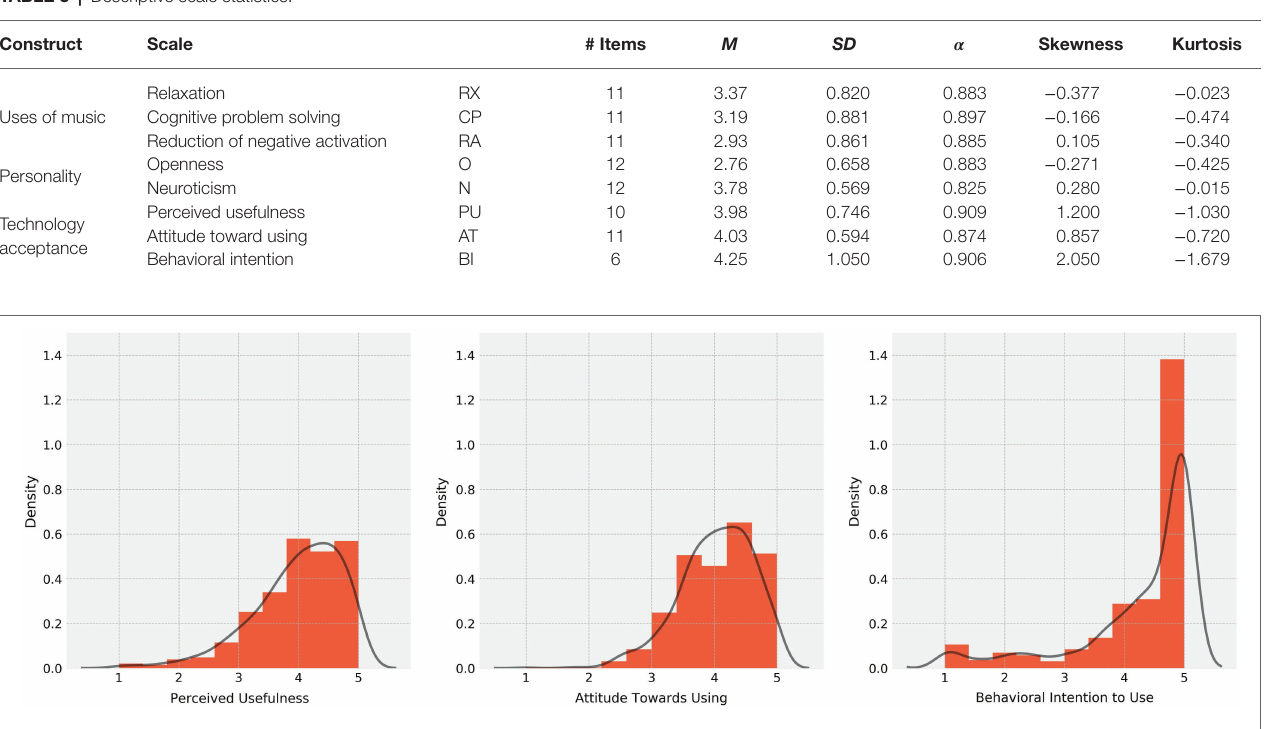
FIGURE 3 | Distributions of the TAM variables “perceived usefulness,” “attitude toward using,” and “behavioral intention to use.” Lines show kernel density